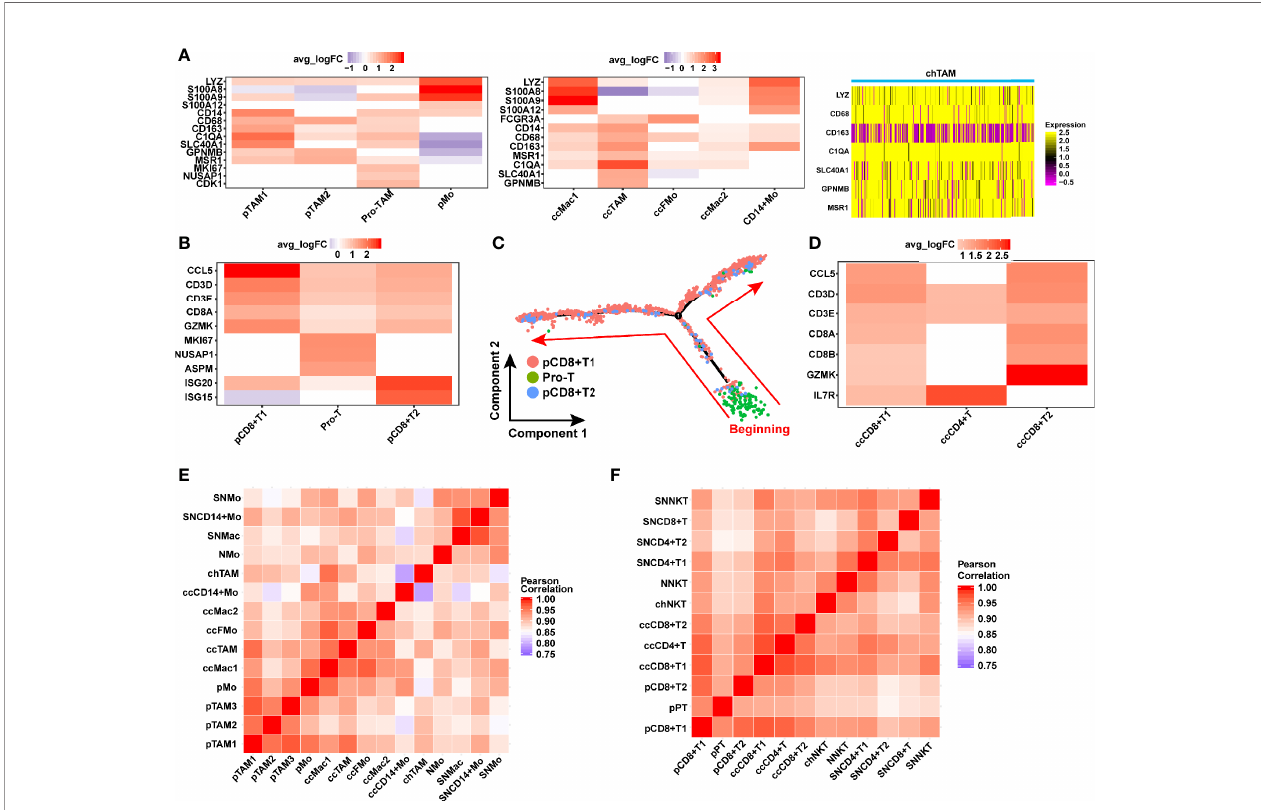
FIGURE 8 | Identi fi cation of the macrophage and T cell in TME of RCC. (A) Gene markers distinguishing the various types of macrophage in different TMEs of RCC. (B, D) Heat map showing gene expression of T cell in pRCC and ccRCC. (C) Monocle2-generated pseudo-temporal trajectory of three types of T cell. The arrows represent the direction of cell evolution. (E, F) Comparison of the correlation of TAM and T cells between tumor and normal kidney. (SN: Science paper ’ s normal kidney, Mo, monocytes; Mac, macrophage; FMo, FCGR3A + monocyte; N, normal kidney in this study; ch, chRCC; cc, ccRCC; p, pRCC; TAM, tumor-associated macrophage; NKT, natural killer T cell; pPT, pro-T cells in